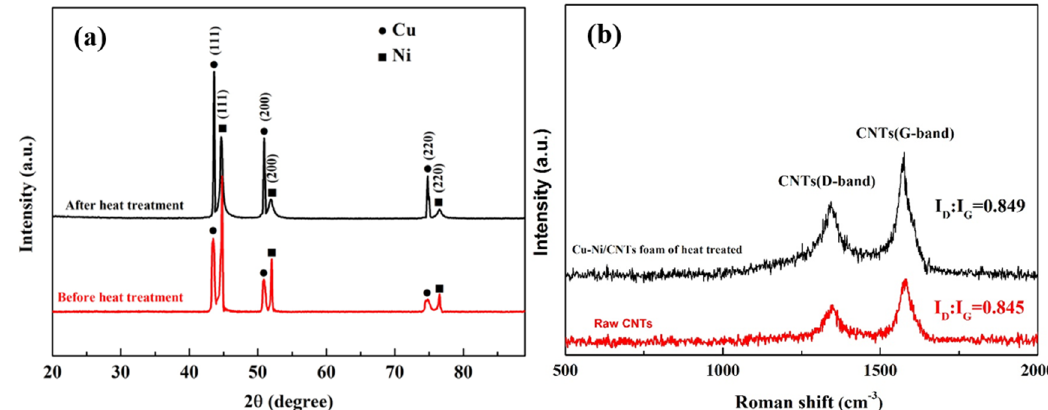
Figure 5. ( a ) The XRD diffraction of Cu-Ni/CNTs foam before and after heat treatment; ( b ) Raman spectra of raw CNTs and Cu-Ni/CNTs foam after heat treatment.